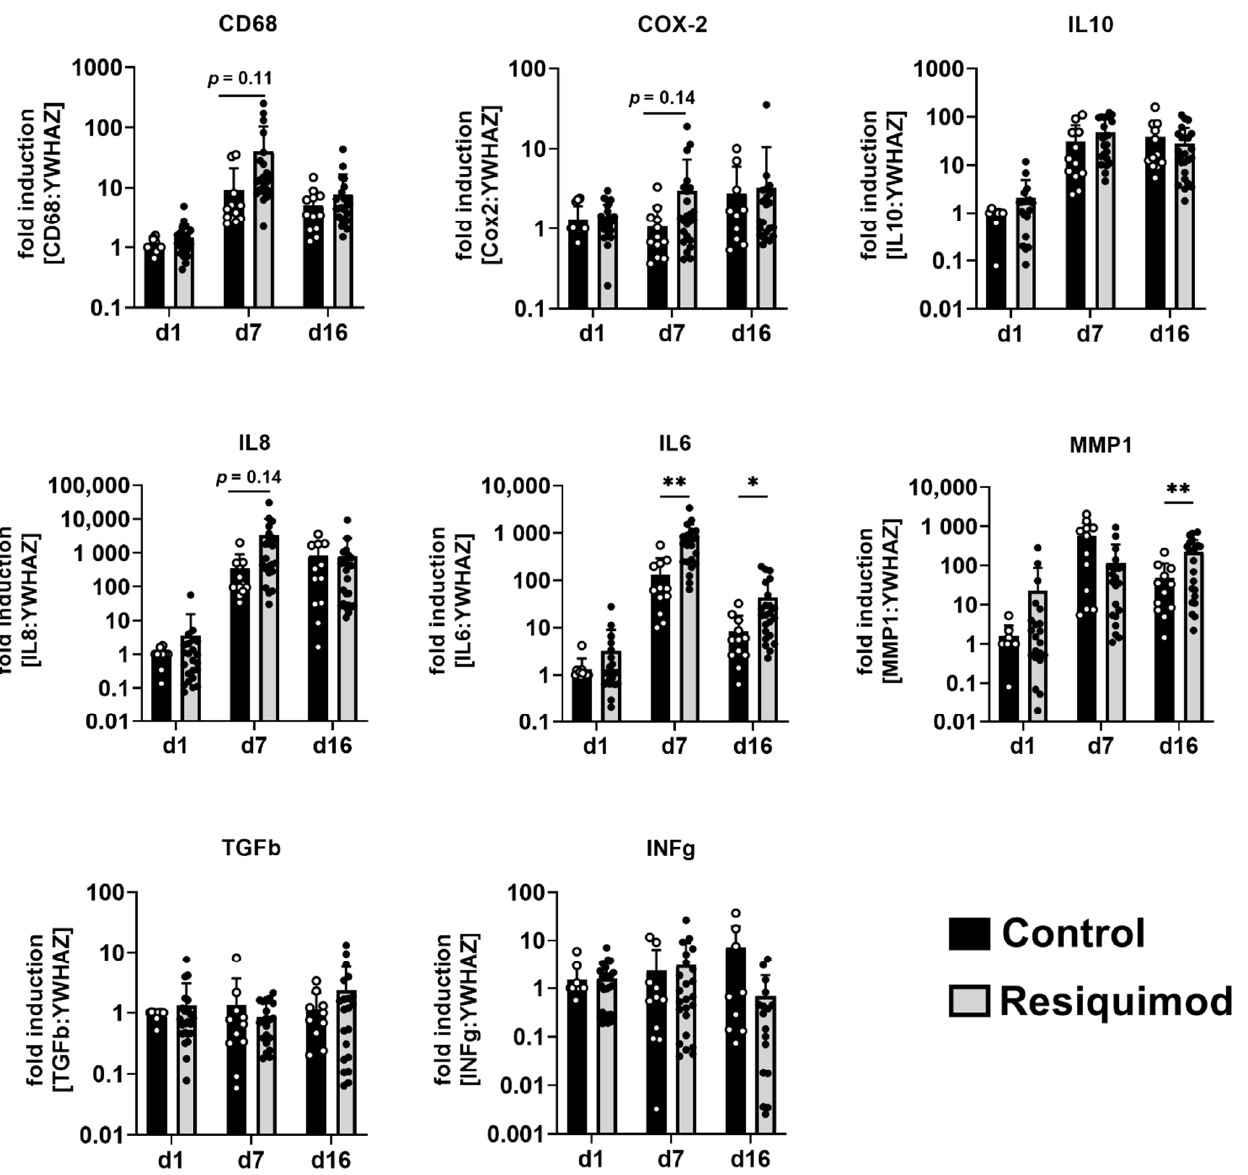
Figure 4. Resiquimod-induced inflammation increased the expression of IL6, MMP1, CD68, IL8 and COX-2. Relative mRNA expression levels of CD68, COX-2, IL10, IL8, IL6, MMP1, TGFb and INFg were determined by qPCR, normalising target gene expression to the averaged expression of YWHAZ. Resiquimod-induced wounds (grey) were compared to control wounds (black). Data are presented as mean (bar) + standard deviation (whiskers) (n = 9–12 for controls and 17–24 for resiquimod application). Data shown as mean + SD. Statistical significance has been determined by 2-way ANOVA and corrected for multiple comparisons using the Sidak method. * ( p < 0.05), ** ( p < 0.01).